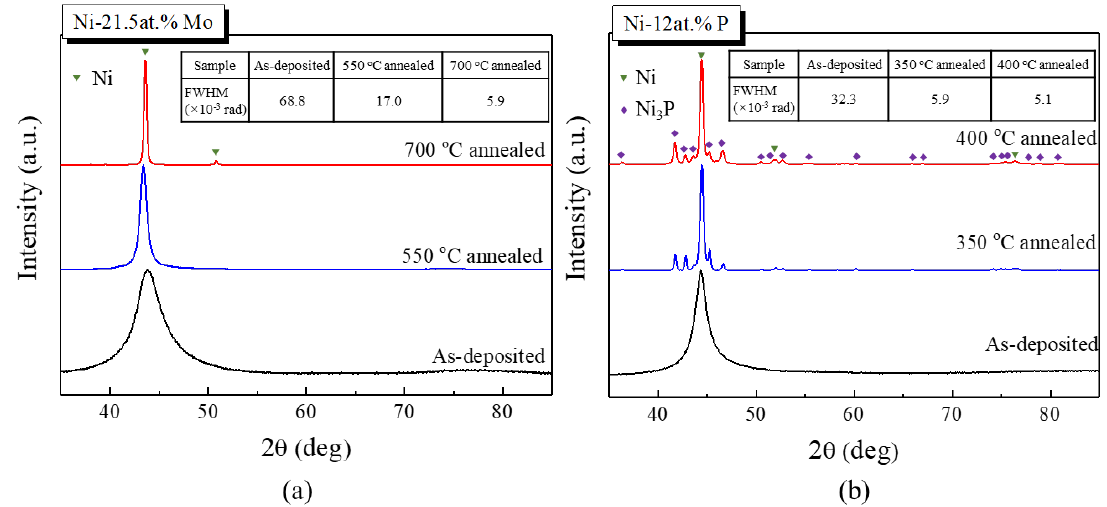
Figure 7. X-ray diffraction patterns of as-deposited and annealed ( a ) Ni-21.5 at.% Mo and ( b ) Ni-12 at.% P. The green nabla in the figures designate the diffraction peaks of Ni and the purple diamonds represent those of Ni 3 P.